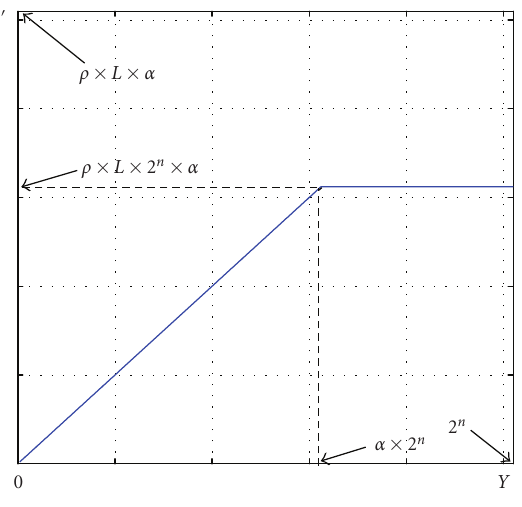
Figure 2: Clipping e ff ect of